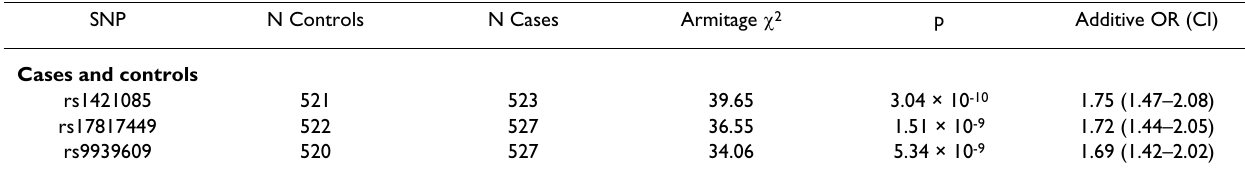
Table 3: Association studies of three FTO SNPs in cases and controls SNP N